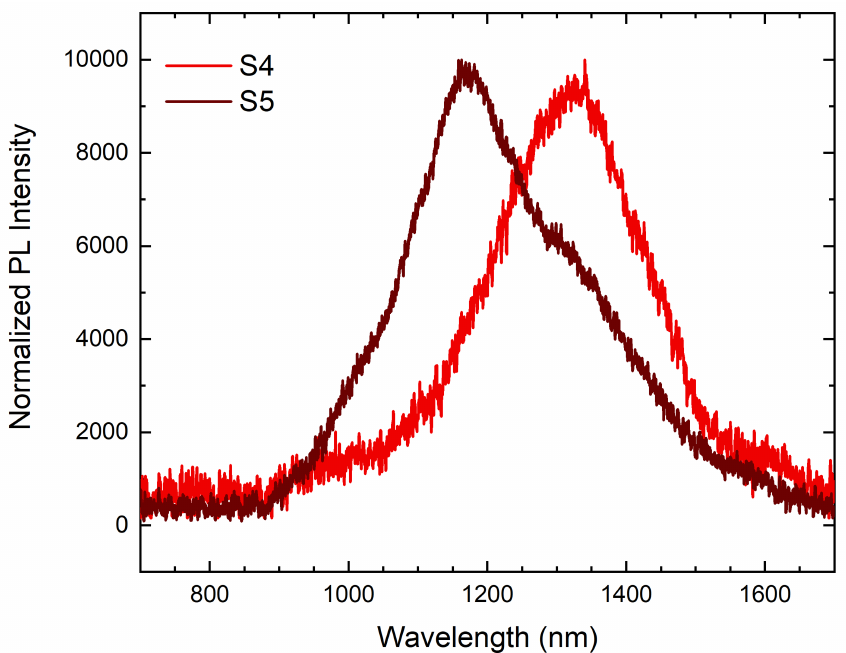
Figure 2. Normalized broadband PL spectrum measured at T = 15 K on Samples S4 (bright red, obtained by capping an identical sample to S1 (shown in Figure 1a) and S5 (dark red, obtained by capping an identical sample to S6 (shown in Appendix A, Figure A1), and excited with a 405 nm laser with power density of ∼ 4.5 kW · cm − 2